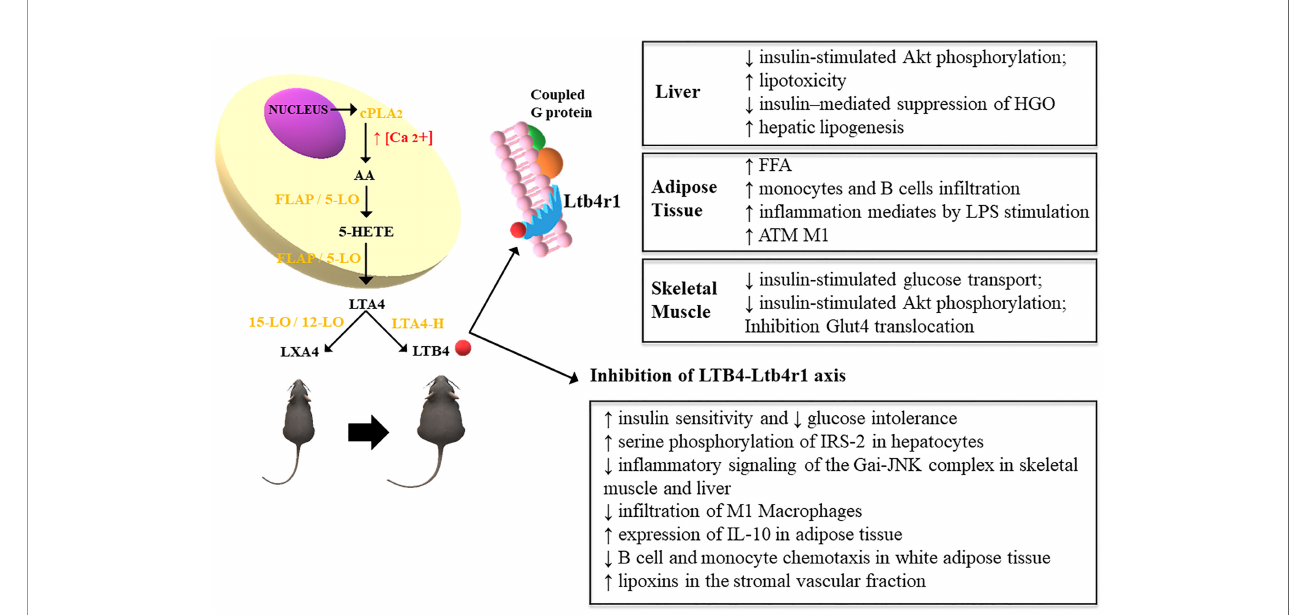
FIGURE 1 | Leukotriene synthesis occurs from the release of arachidonic acid and the action of cytosolic phospholipase A2 (cPLA2) due to the increase in intracellular calcium, which increases the expression of 5-lipoxygenase (5-LO), which translocates to the cell nucleus by interacting with 5-LO membrane anchor activating protein (FLAP). This leads to the formation of 5-hydroperoxyeicosatetraenoic acid (5-HETE) which gives rise to the formation of LTA4, converted to LTB4 by the action of the enzyme LTA4 hydrolase (LTA4-H) in obese rodents. In turn, lean animals convert LTA4 into lipoxins (LXA4) through the action of the enzyme 15/12-LO (12). The increased expression of LTB4 exerts in fl ammatory effects through the high-af fi nity interaction with its G protein-coupled receptor, Ltb4r1. This mechanism impairs the metabolism of glucose and fatty acids in the liver, TA and skeletal muscle. These effects are attenuated through the pharmacological inhibition of LTB4R1